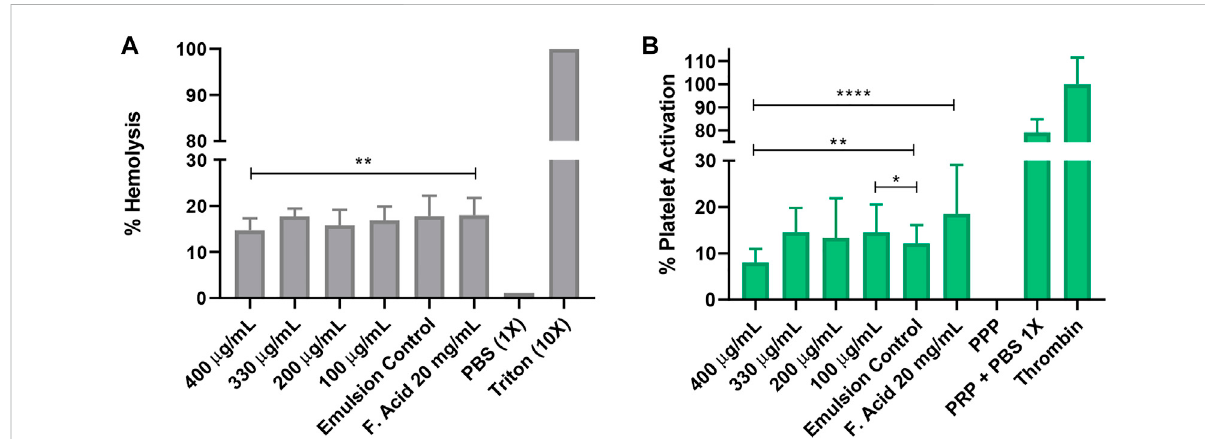
FIGURE 8 Biocompatibilityassays. ThetestedtopicalswerepreparedwiththeMNPs-PEG8-BUF-II-Agnanobioconjugates(400,330,200and100 μ g/ml) at 60% wt. and HLB of 14. The emulsion prepared in the absence of the nanobioconjugates and a commercial topical based on fusidic acid were employed as controls. In the hemolysis assay (A) Triton X-100 was used as the positive control, while PBS 1X was the negative one. In the platelet